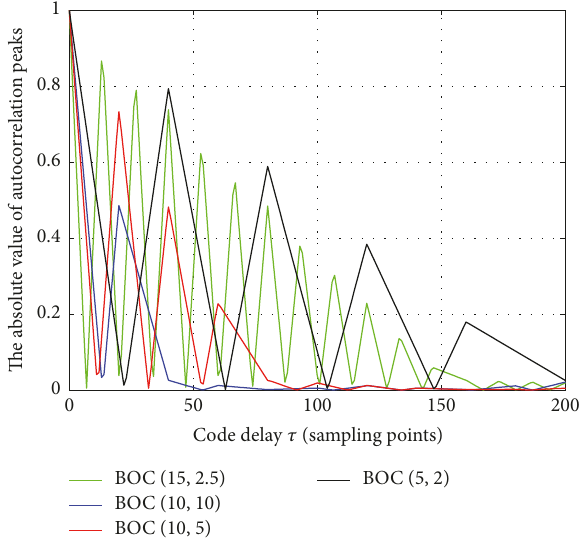
Figure 5: The absolute values of the autocorrelation peaks for the BOC